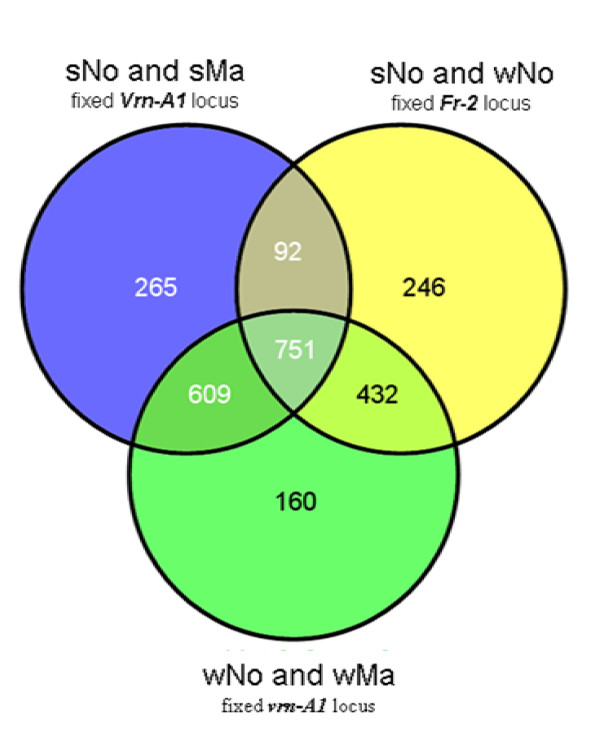
Genes controlled by the Vrn-A1 and Fr-2 loci. Venn diagrams showing the statistically significant (P < 0.001) differentially expressed genes that show GxT interaction in genotypes with neutralized Vrn-A1 or Fr-2 locus.